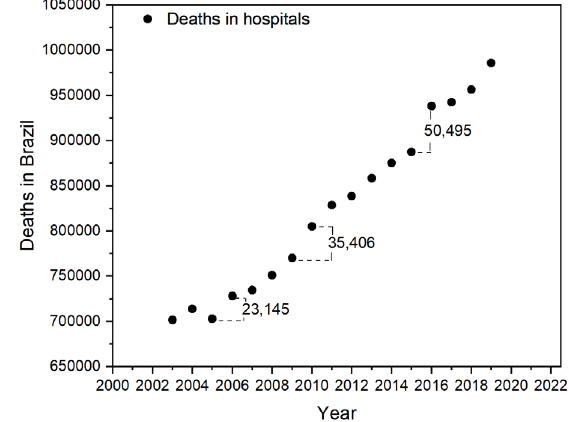
Figure 3. Number of deaths registered in hospitals in Brazil between 2003 and 2019. In this graph, as in Figure 1, the differences between the years 2005 and 2006, 2009 and 2010, and 2015 and 2016 are